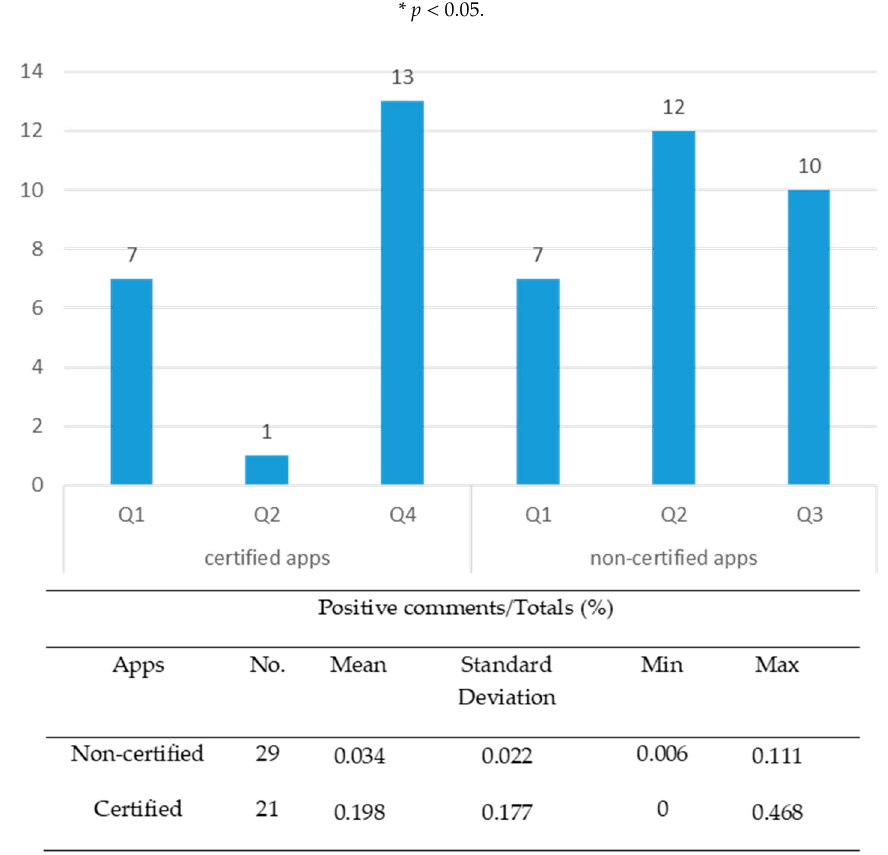
Figure 2. Distribution of apps according to the user opinion ranking ( n = 50 apps).